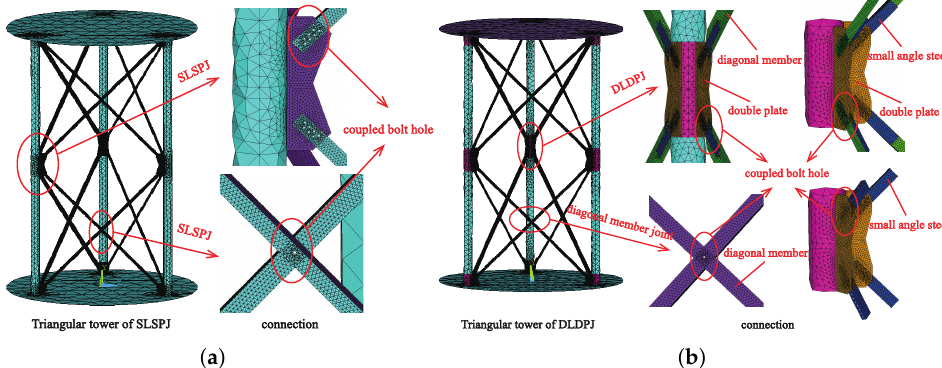
Figure 10. ( a ) The finite element model of triangular tower with the SLSPJ. ( b ) The finite element model of triangular tower with the DLDPJ.